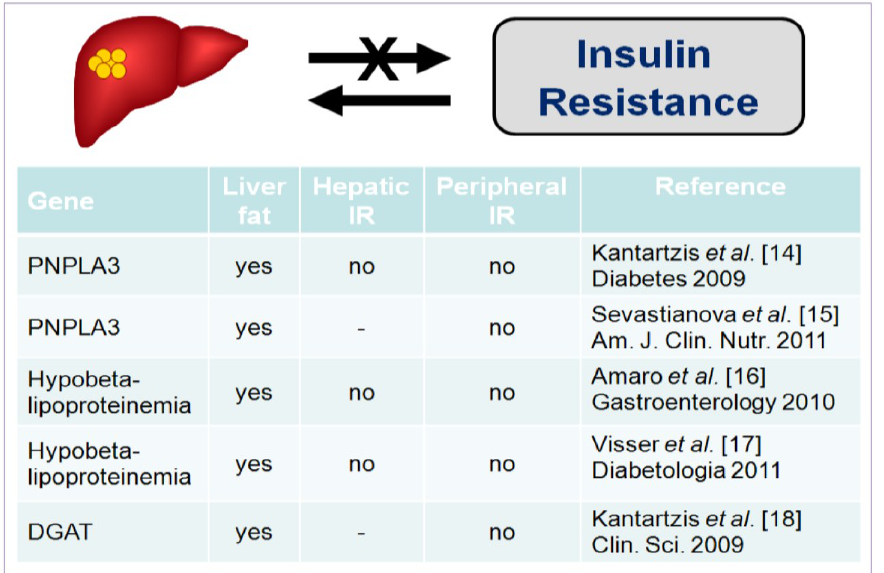
Figure 1. Non-alcoholic fatty liver disease (NAFLD) is not a primary determinant of insulin resistance, since subjects with hepatic TG accumulation due to genetic predisposition have a degree of hepatic and/or peripheral insulin resistance comparable to subjects without